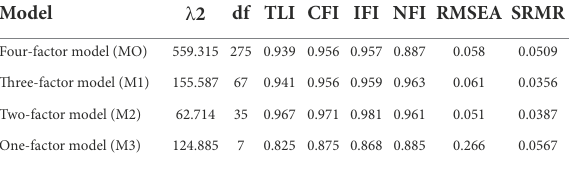
TABLE 5 Results of model comparisons using a CFA approach.